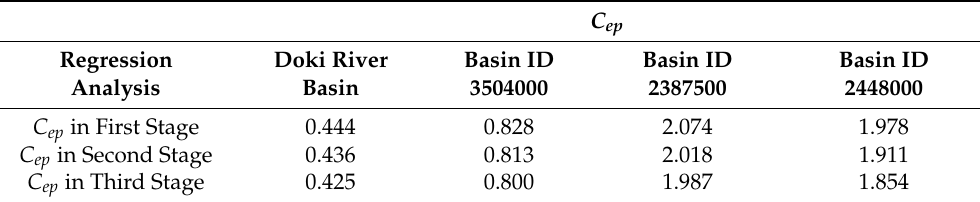
Table 5. Comparison of C ep values before and after the removal of